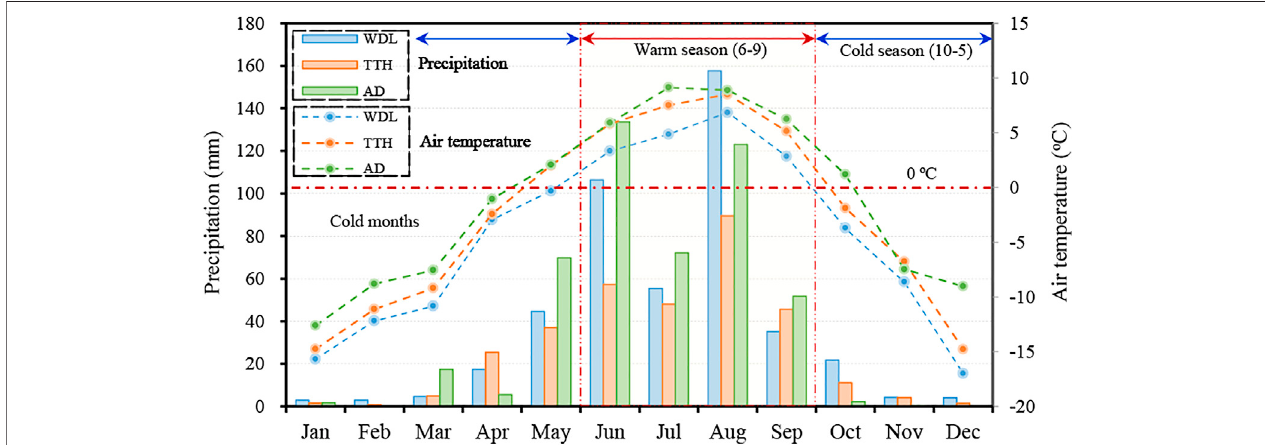
FIGURE2| MonthlymeanairtemperatureandprecipitationforWDL,TTH,andADweatherstationsin2019.ThemeanannualtemperaturesatWDL(1957 – 2019), TTH (1957 – 2019), and AD (1966 – 2019) were − 5.1 ° C, − 3.8 ° C, and − 2.4 ° C, respectively, and mean annual precipitation totals were 299, 293, and 445 mm in the same period (China Meteorological Data Sharing Service System,